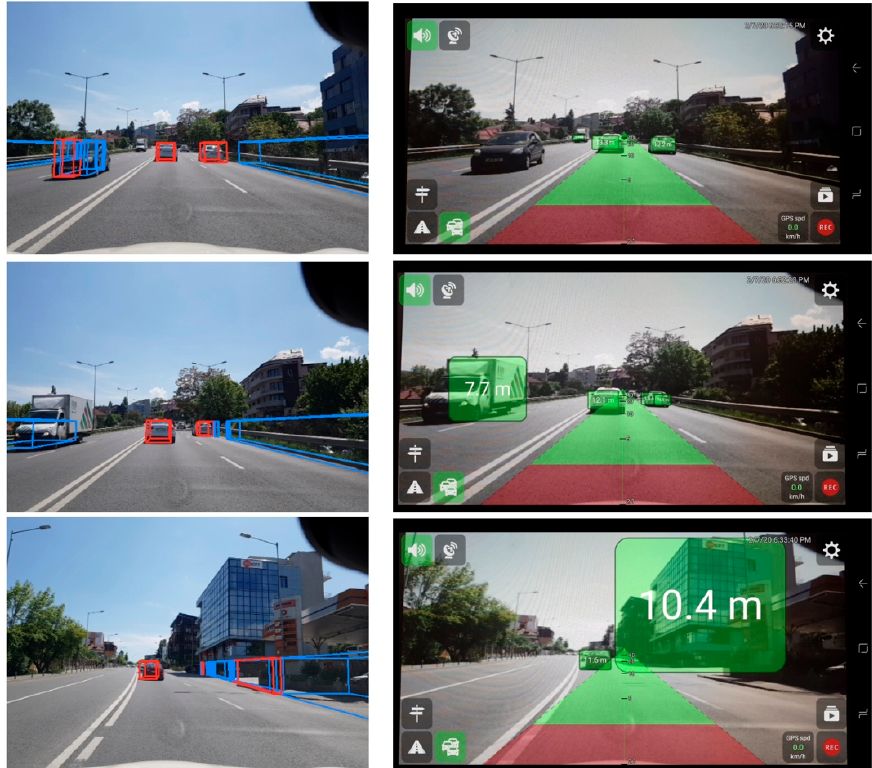
Figure 15. Comparison with a CNN ‐ based detector running on mobile devices. Left column—our approach, right column—UGV Driver